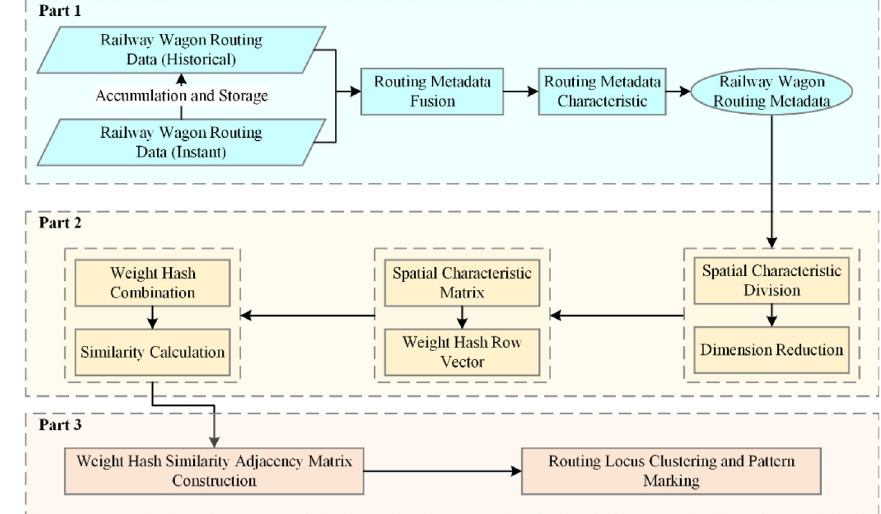
Figure 3. The total fl ow chart of the intelligent recognition SST- based